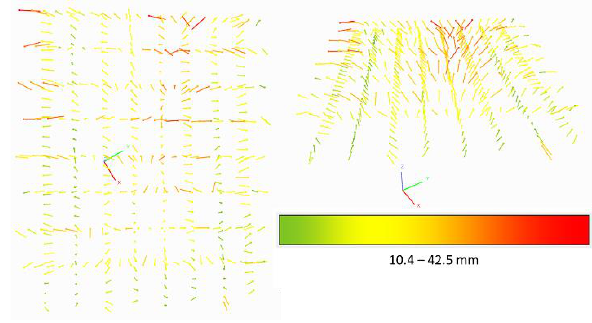
Figure 11. Resulting changes in exterior orientation translation parameters for ZenmuseX4s (data set 2) (graphic from AICON 3D Studio).